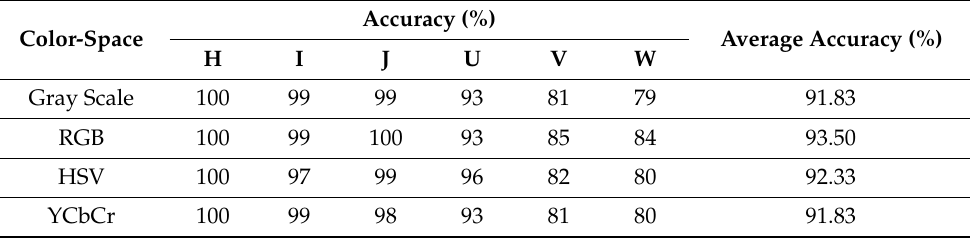
Table 11. Comparison of the results obtained using different color-spaces with occlusion by sunglasses. Color-Space